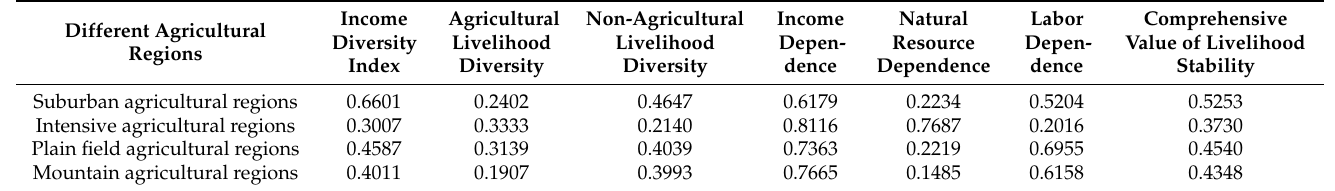
Table 5. Comparison of livelihood stability per household in different agricultural regions.